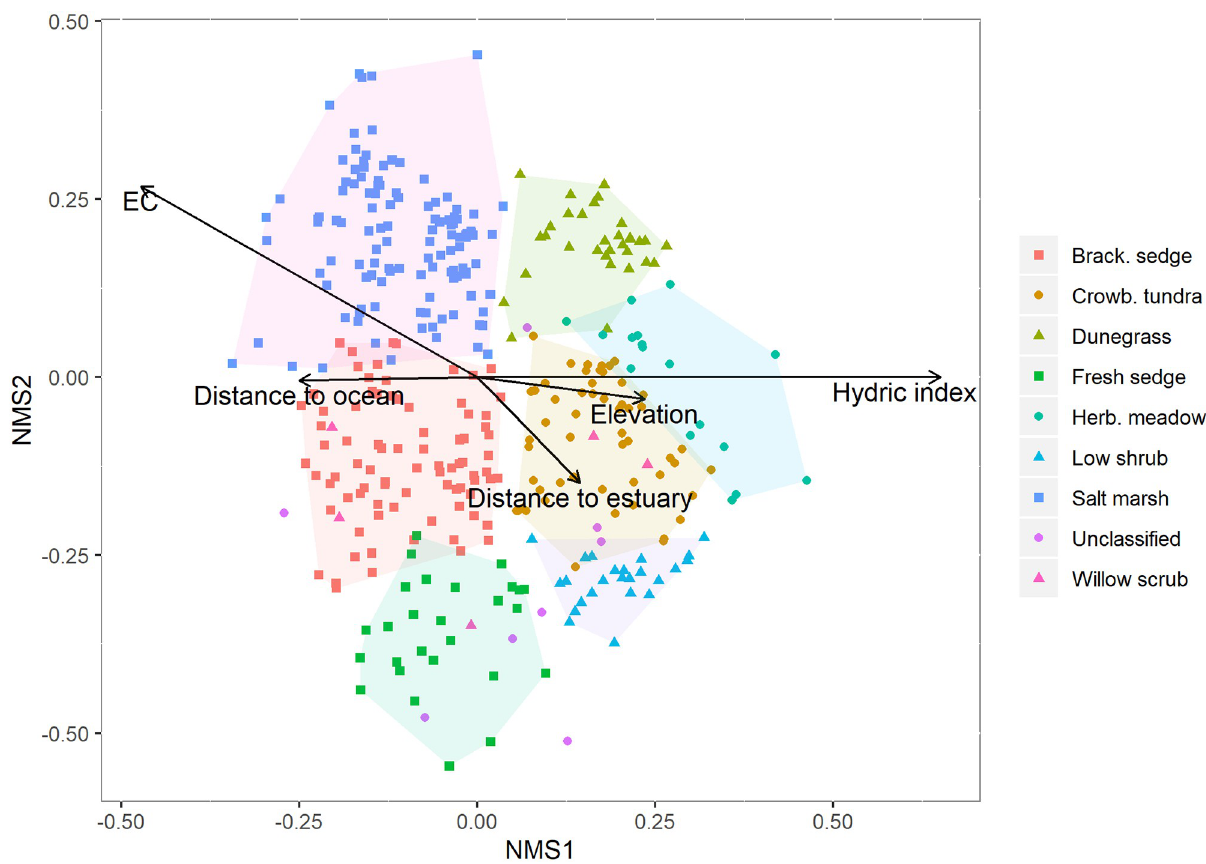
Fig 4. Ordination of plots using NMS. The point cloud was rotated to align the hydric index maximally with Axis 1. The 5 variables most correlated with Axes 1 and 2 are displayed (Table 3). Colored symbols refer to the vegetation classes, defined in Table 2. Classes were grouped by convex hulls, with Willow Scrub and unclassified plots